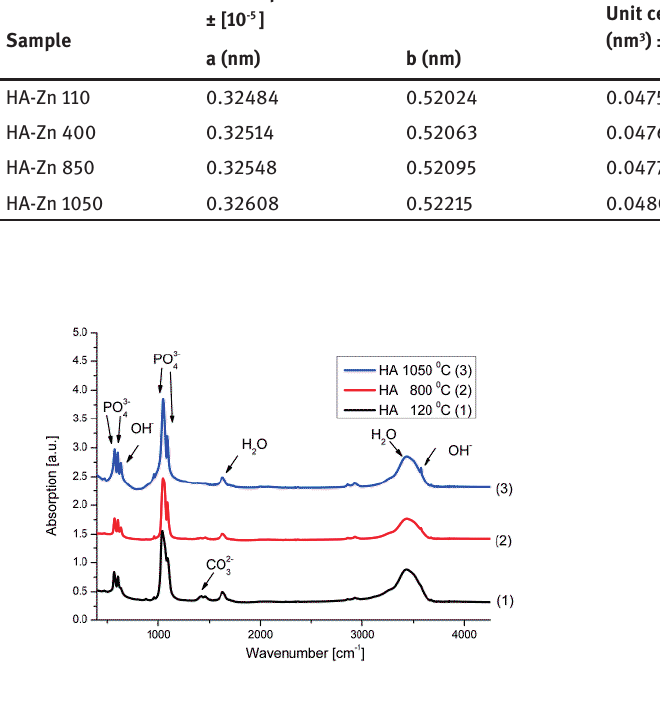
Figure 2: FT-IR spectra of HA.